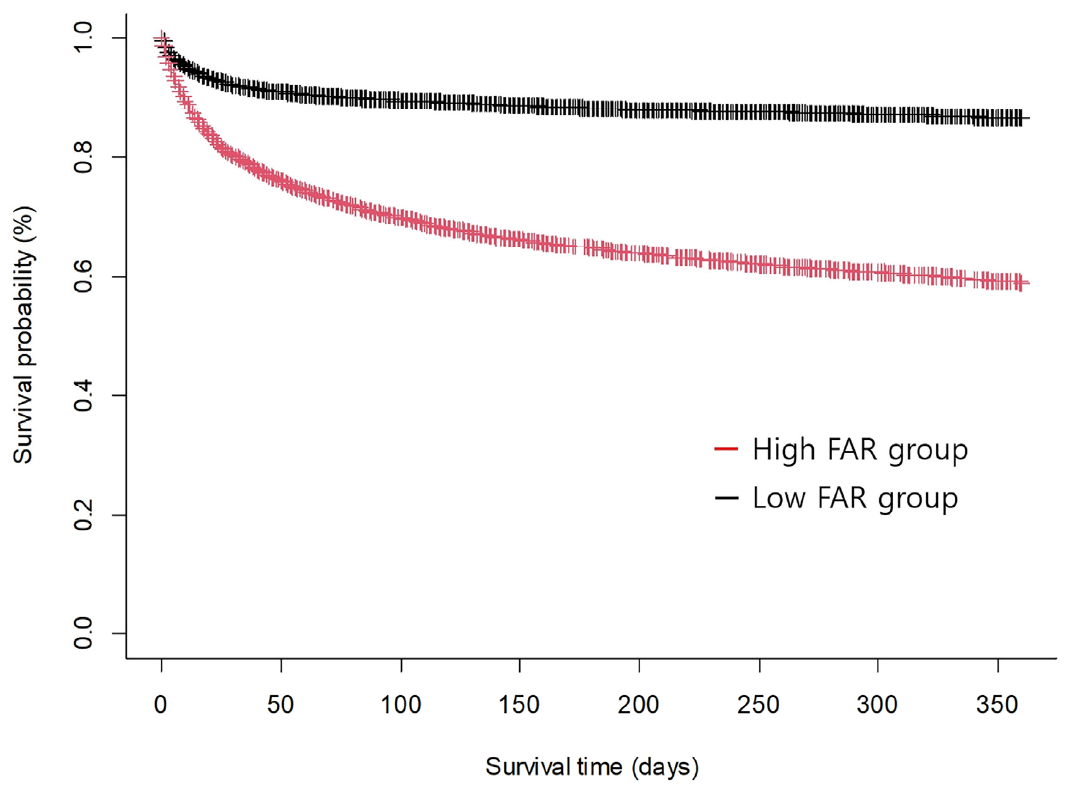
Figure 2. Kaplan–Meier curves for 1-year mortality according to fibrinogen/albumin ratio (FAR) upon intensive care unit admission (hazard ratio, 3.47; 95% confidence interval, 3.25–3.70; p < 0.001).